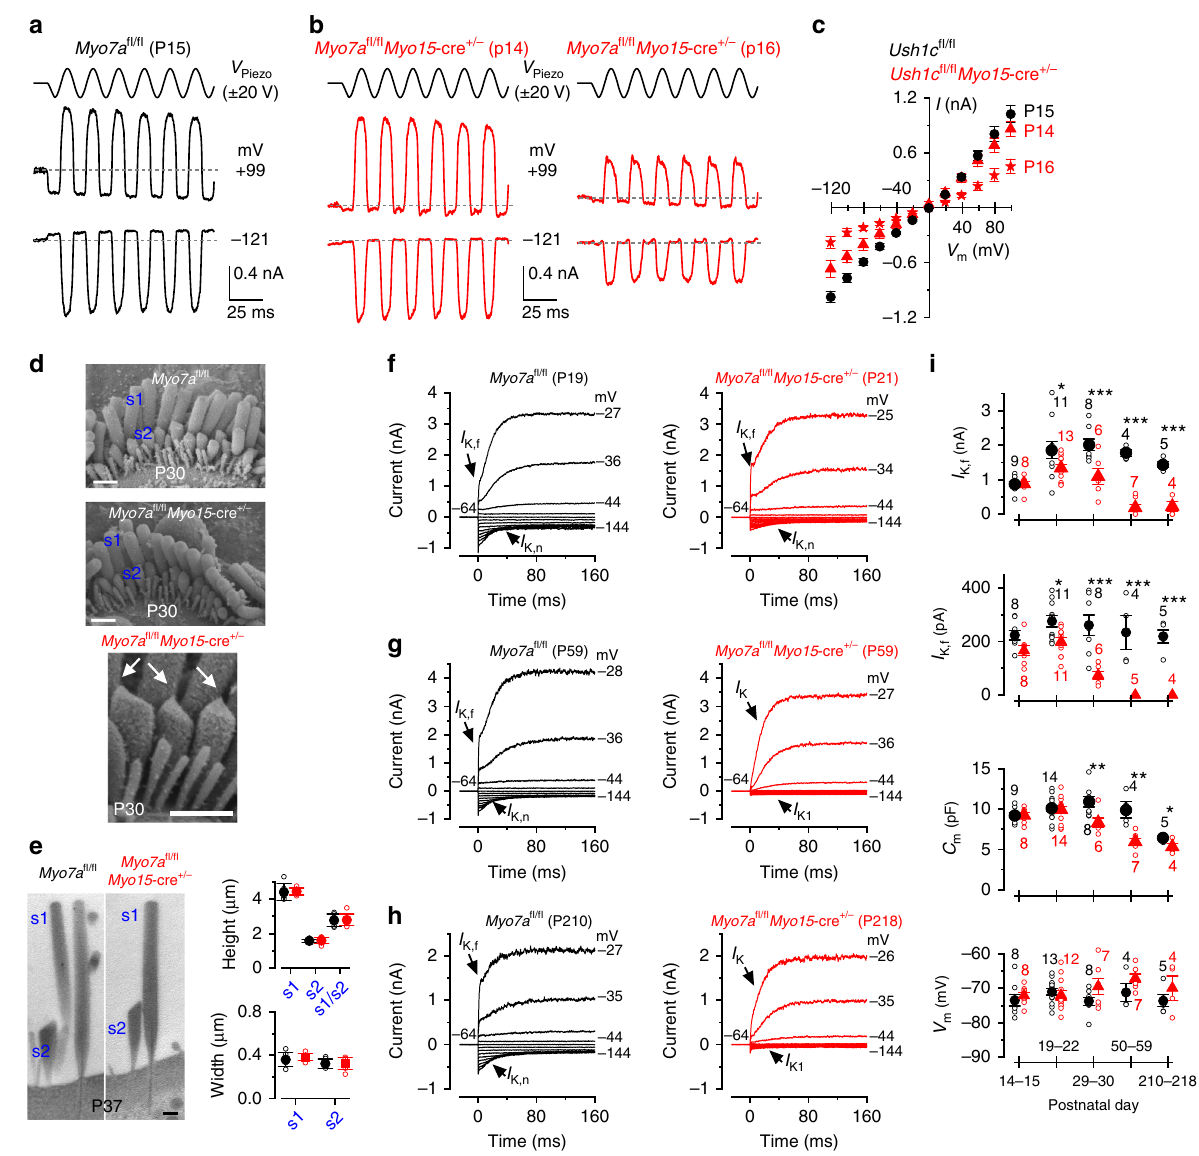
Fig. 5 The functional MET current is required for retaining mature IHC characteristics. a , b MET currents recorded from mature IHCs of control Myo7a fl / fl ( a , P15) and Myo7a fl / fl Myo15 -cre + /- ( b , P14 and P16) mice. Protocol as in Fig. 2a. c Peak-to-peak MET current-voltage curves obtained from six P15 Myo7a fl / fl (2 mice), four P14 Myo7a fl / fl Myo15 -cre + /- and six P16 Myo7a fl / fl Myo15 -cre + /- IHCs (3 mice). d Scanning electron microscopy images showing the stereociliary bundle of apical-coil IHC from P30 control Myo7a fl / fl and Myo7a fl / fl Myo15 -cre + /- mice. s1 and s2 represent the tallest and the second tallest stereocilia, respectively. The arrows in the middle panel highlights that tip links, which are required to gate the MET current, are present in Myo7a fl / fl Myo15 - cre + /- IHCs. Scale bars, 1 μ m. e Transmission electron microscopy images (left) showing the stereocilia s1 and s2 (see panel d ) of apical-coil IHCs from P37 control Myo7a fl / fl and Myo7a fl / fl Myo15 -cre + /- mice. Scale bars, 400 nm. The right panels show that the height and width of s1 and s2 stereocilia in IHCs are comparable between the two genotypes ( Myo7a fl / fl s1: height 4.42 ± 0.48 μ m, width 0.36 ± 0.07 μ m, n = 6 IHCs, s2: height 1.58 ± 0.10 μ m, width 0.32 ± 0.04 μ m, n = 7, s1/s2: 2.77± 0.36, n = 6; Myo7a fl / fl Myo15 -cre + /- s1: 4.44 ± 0.20 μ m, P < 0.8915, 0.38 ± 0.03 μ m, P < 0.4441, n = 7, s2: 1.61 ± 0.18 μ m, P < 0.7849, 0.33 ± 0.06 μ m, P < 0.8959, n = 7, s1/s2: 2.80 ± 0.35, P < 0.9059, n = 6). f – h Potassium currents recorded from IHCs of young adult ( f , P19 and P21), adult ( g , P59) and aged ( h , P210 and P218) control Myo7a fl / fl (left panels) and Myo7a fl / fl Myo15 -cre + /- (right panels) mice. Protocols are as in Fig. 3a. i Size of I K,f , I K,n , membrane capacitance ( C m ) and resting membrane potential ( V m ) as a function of postnatal age. Number of IHC investigated is shown above or below the symbols (for more details see Supplementary Table 3). Statistical tests are performed with two-way ANOVA with Bonferroni correction. Average data is shown as mean ± SEM ( c , i ) or mean ± SD ( e